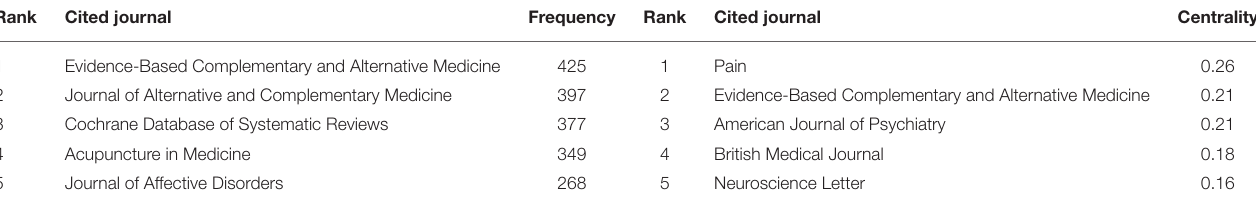
TABLE 2 | Top five frequencies and centrality of cited journals related to acupuncture on depression.